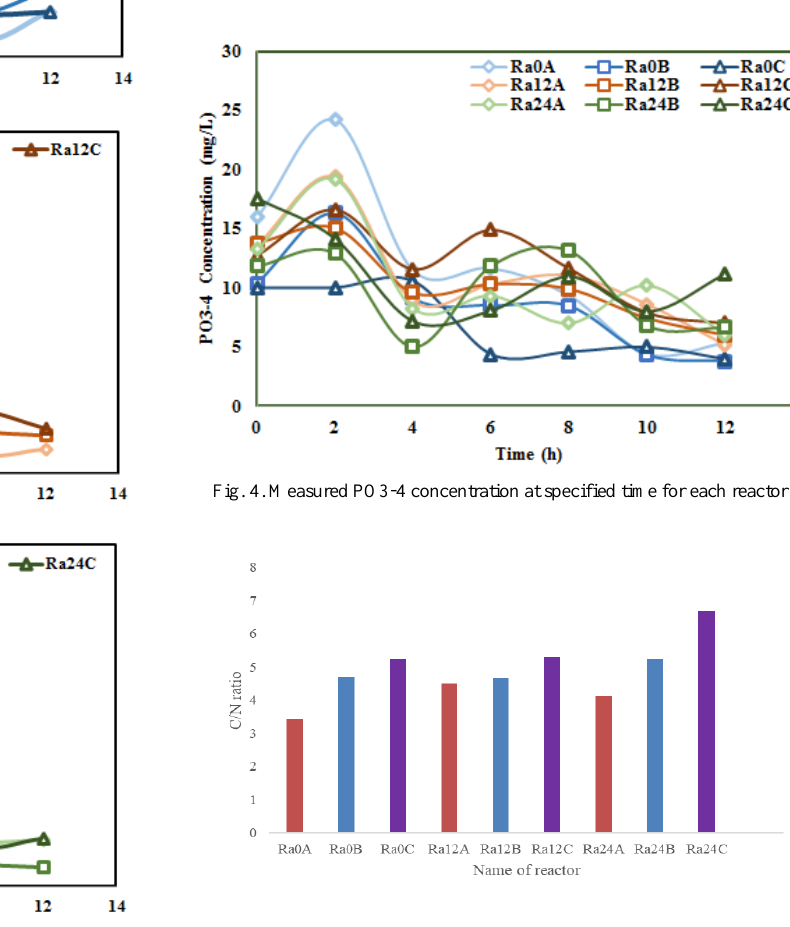
Fig. 5. Initial C/N ratio for each reactor Chlorophyll is a green pigment in plants, algae and photosynthetic bacteria. Therefore, in this study, the